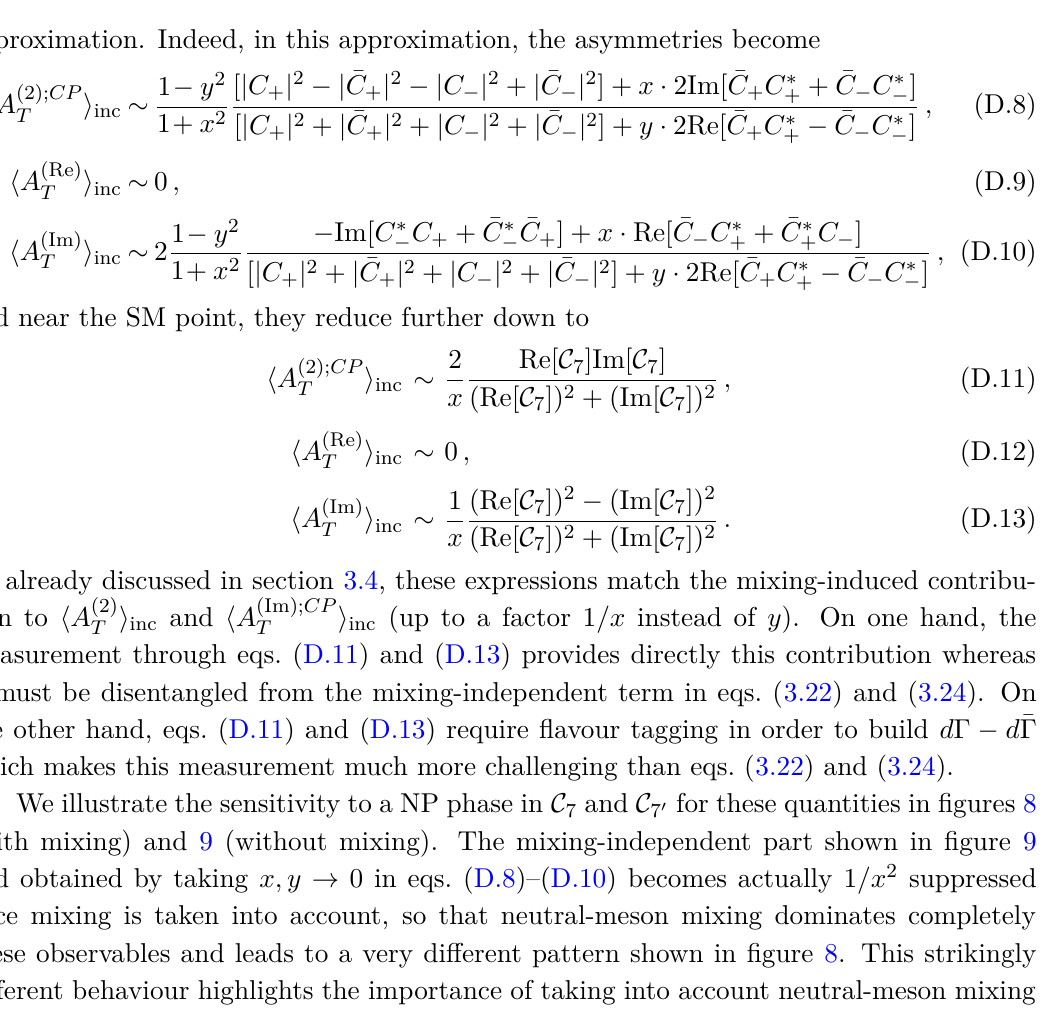
Figure 8 . Variation with θ of h A (2); CP The selected NP scenarios are shown taking into account meson-mixing